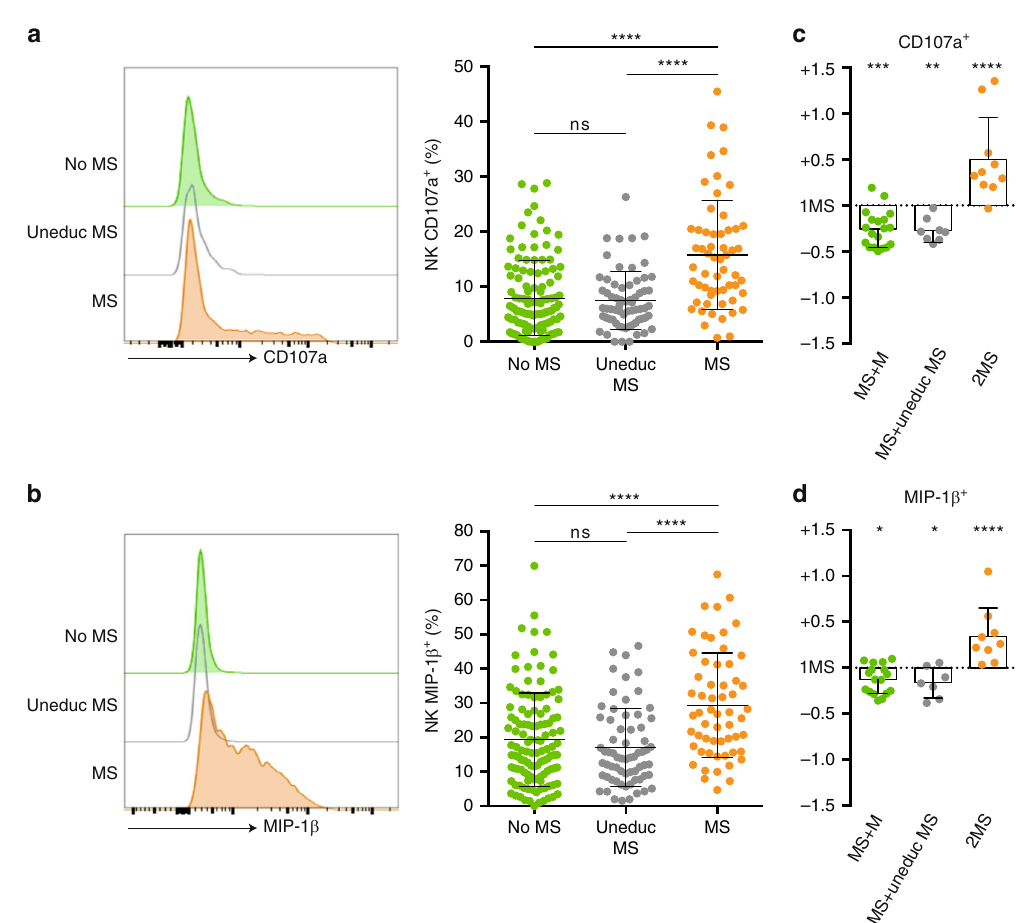
Fig. 4 Allogeneic endothelial cells trigger missing self-induced activation of NK cells. Primary allogeneic human endothelial cells were co-cultured with puri fi ed NK cells from 30 healthy volunteers primed with low-dose IL-2. After 4 h of culture the activation status of the NK cells was assessed at the single cell level by fl ow cytometry. a , b Analyses were focused on the fi ve NK cell populations that expressed a single inhibitory KIR. a Expression of CD107a (LAMP-1) on NK cell surface after 4-h co-culture. Left panel: representative fl ow cytometry pro fi les. Middle panel: individual values of NK cell populations according to their status against primary allogeneic human endothelial cells. b Intracellular staining for MIP-1 β in NK cells after 4-h co-culture. Left panel: representative fl ow cytometry pro fi les. Middle panel: individual values of NK cell populations according to their status against primary allogeneic human endothelial cells. c , d Analyses were focused on the NK cell populations that expressed two inhibitory KIRs, one of them lacking its ligand on endothelial cells (missing self, MS). According to the nature of the second inhibitory KIR, three situations were distinguished: 1MS + 1M, if endothelial cells expressed the ligand for the second inhibitory KIR; 1MS + uneduc MS, if neither endothelial cells nor NK cell donor expressed the ligand for the second inhibitory KIR, and 2MS, if endothelial cells did not express the ligands of the two inhibitory KIRs. Results are normalised over the value observed for the NK cell population that expressed the single mismatched inhibitory KIR. c Expression of CD107a (LAMP-1) on NK cell surface after 4-h co-culture. d Intracellular staining for MIP-1 β in NK cells after 4 h co-culture. ns: p ≥ 0.05, * p < 0.05, ** p < 0.01, *** p < 0.001, **** p < 0.0001; one-way ANOVA. Source data are provided as a Source Data fi